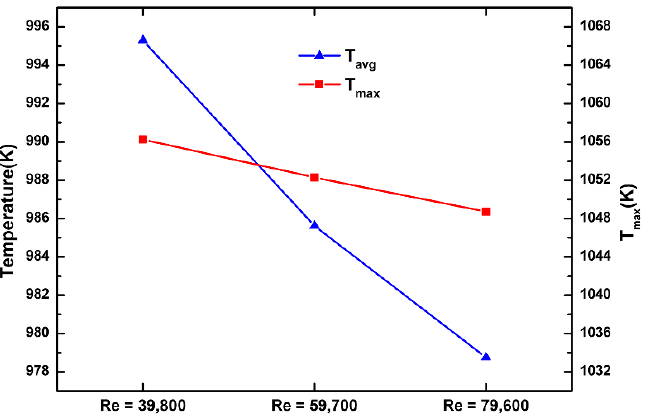
Figure 15. Variation of average temperature of wall_1 with Reynolds number.